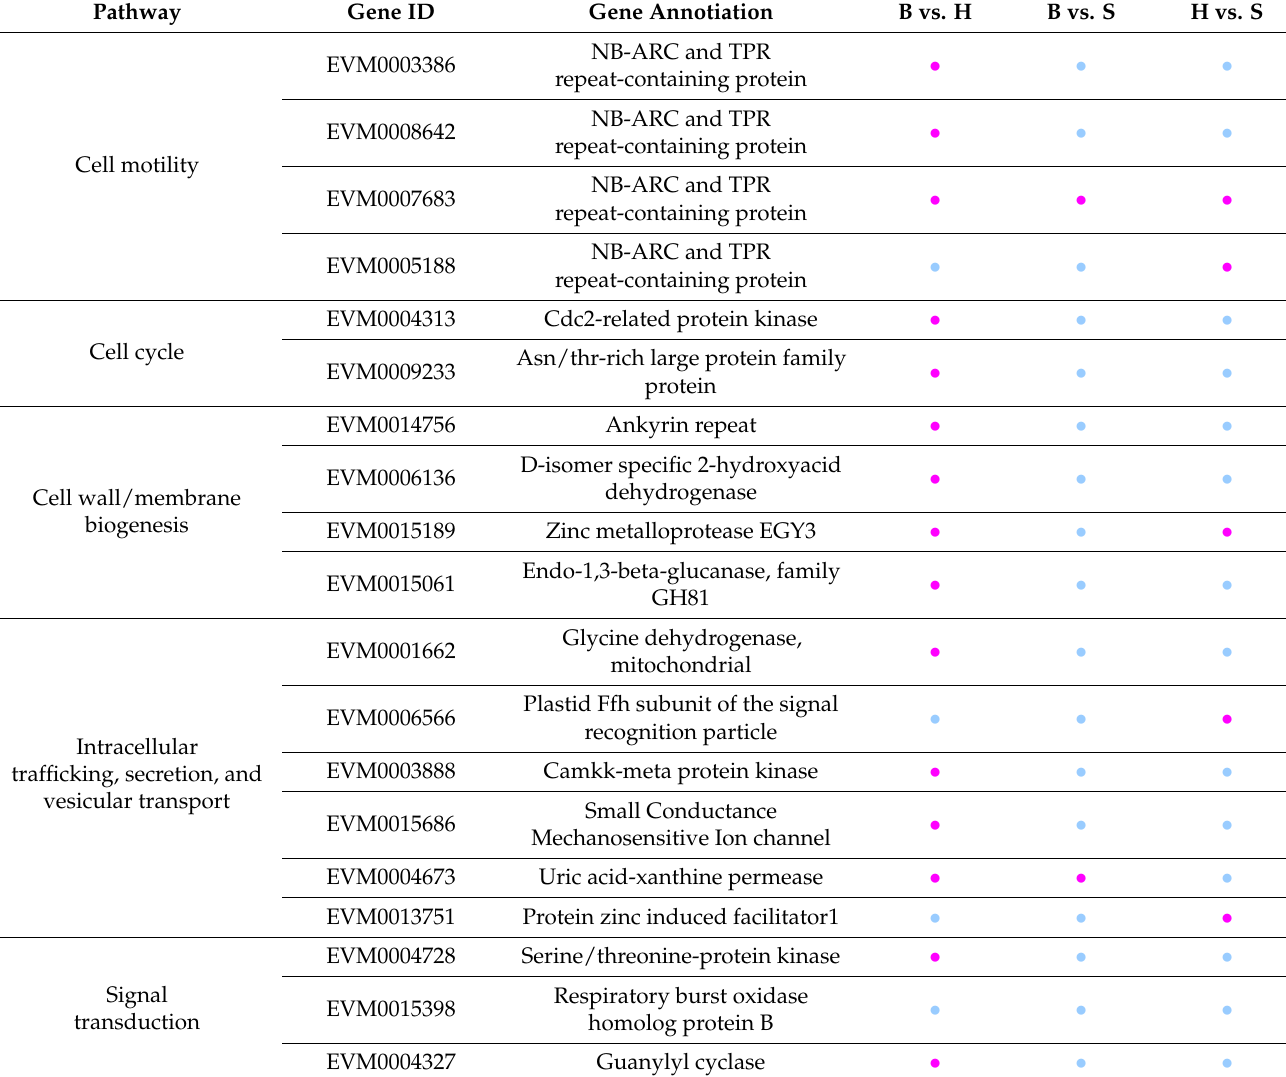
Table 3. The annotations and methylation levels of key DMRs associated genes with holdfast, stipe and blade development.